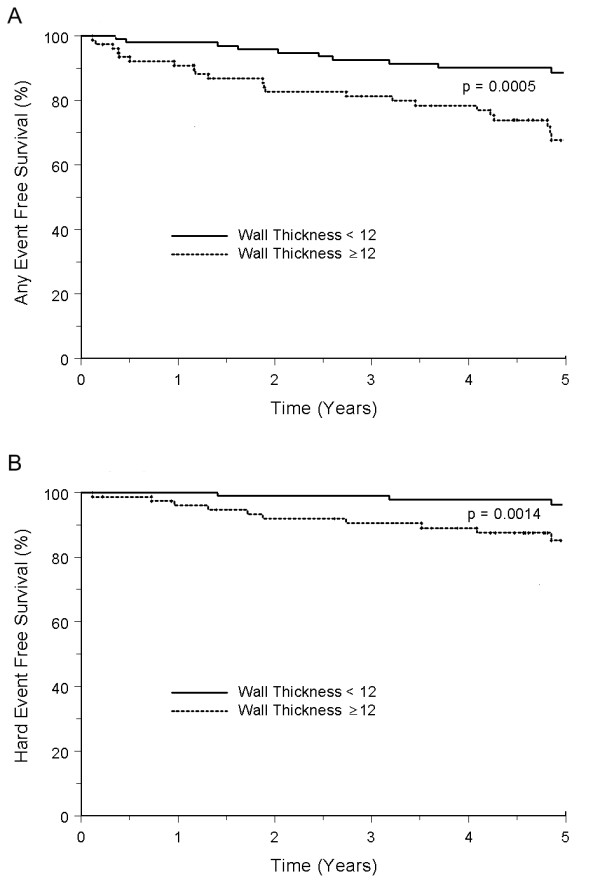
Kaplan-Meier survival curves for participants free from any cardiac event (Panel A), or a hard cardiac event (Panel B). Graphs for individuals with and without LV end-diastolic wall thickness >12 mm are shown.